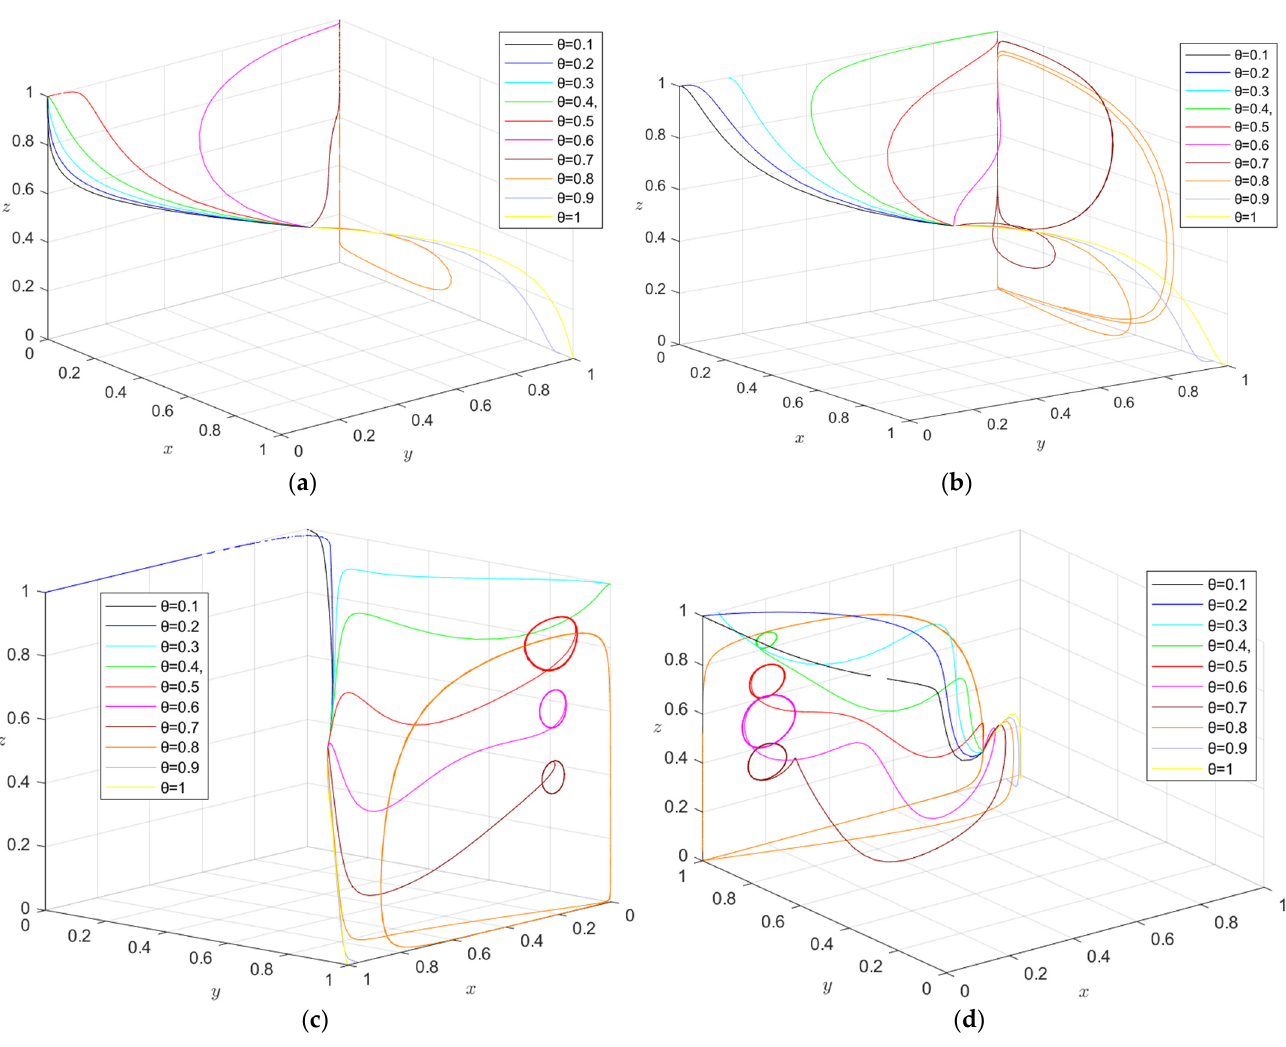
Figure 13. ( a ) Evolution path of developer, general contractor, and government under low supervision quality; ( b ) evolution path of developers, general contractors, and government under lower regulatory quality; ( c ) evolution path of developers, general contractors, and government under higher supervision quality; ( d ) evolution path of developer, general contractor, and government under high supervision quality.